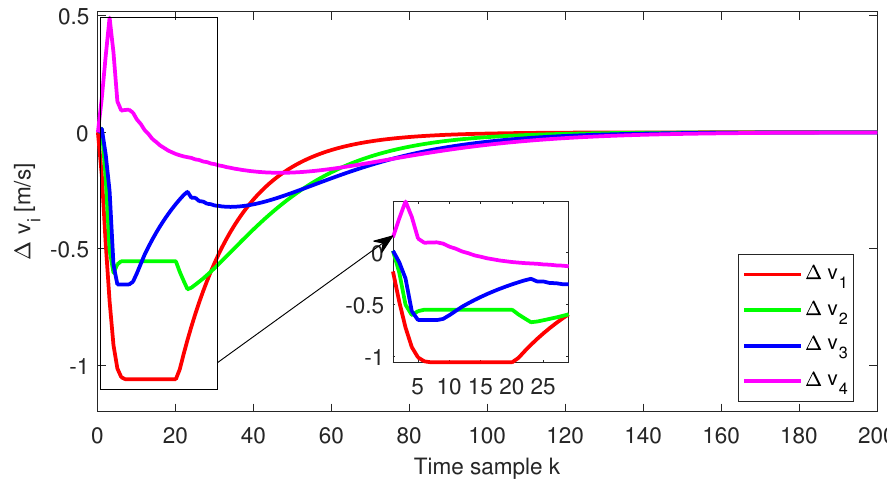
Figure 7. Test 8 —Distance error for each platoon vehicle.